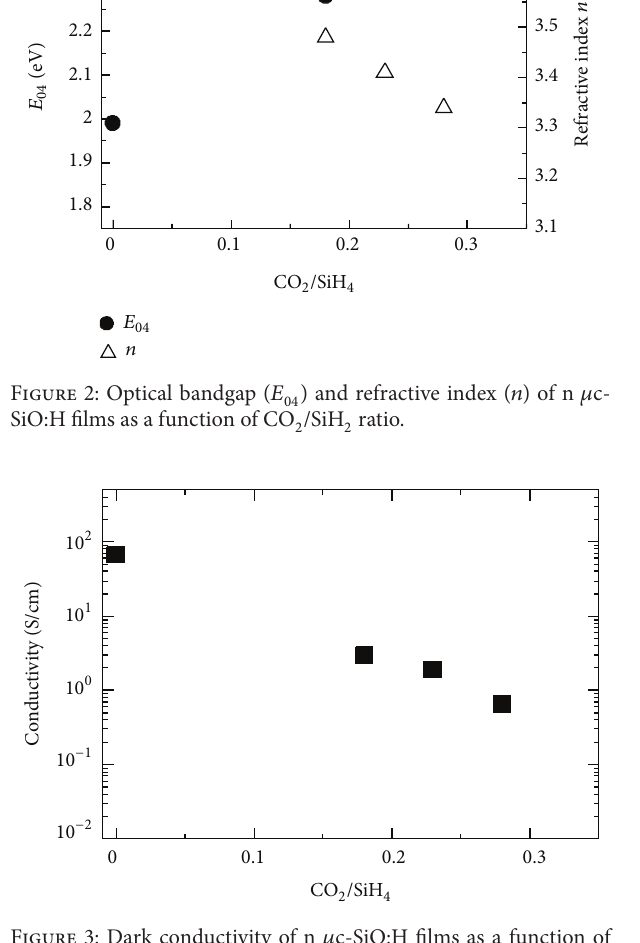
Figure 3: Dark conductivity of n 𝜇 c-SiO:H films as a function of CO 2 /SiH 2 ratio.